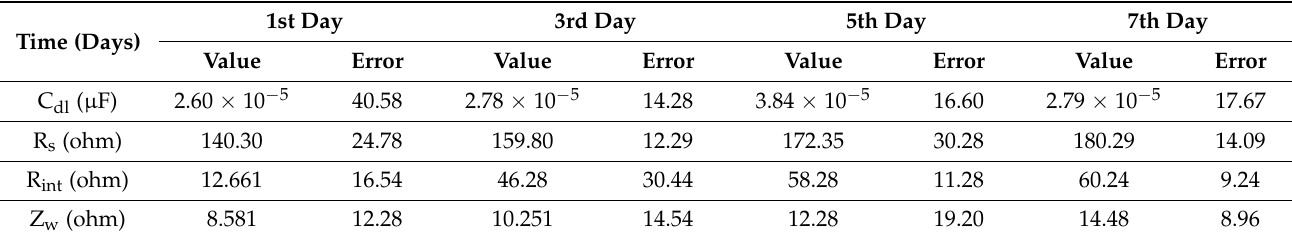
Table 1. EIS data of